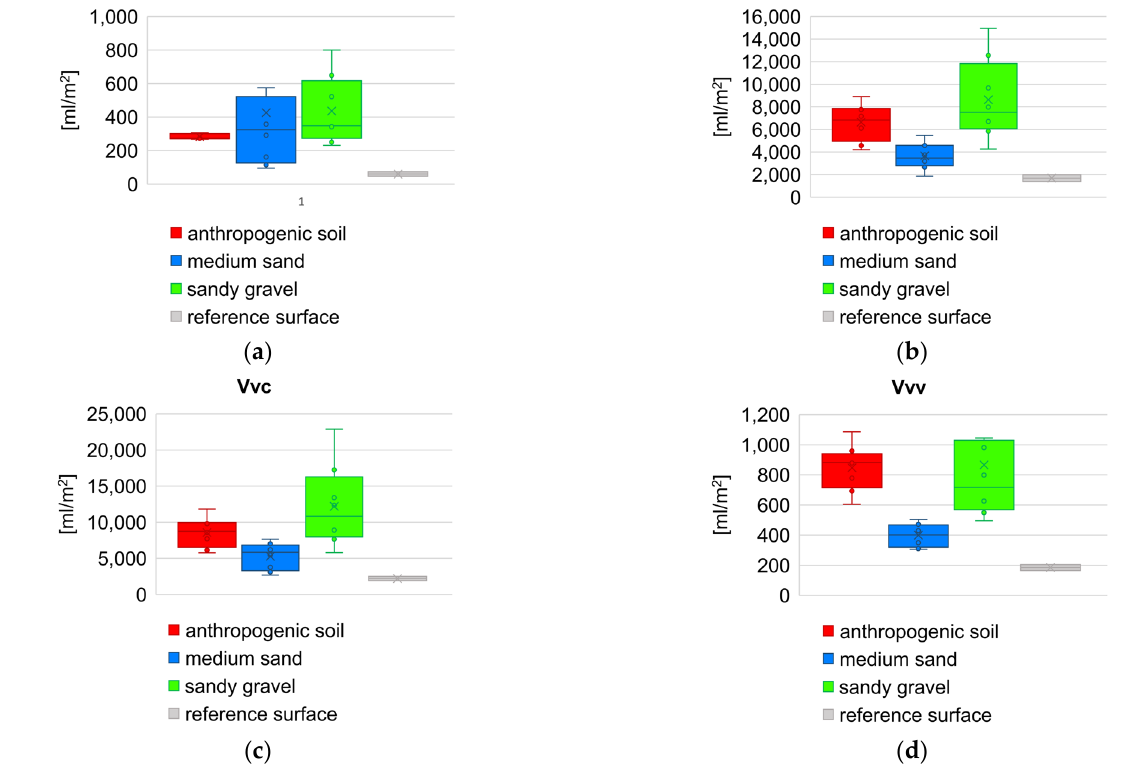
Figure 15. Box plot comparison of functional volume parameters: ( a ) peak material volume; ( b ) core material volume; ( c ) core void volume; ( d ) dale void volume.